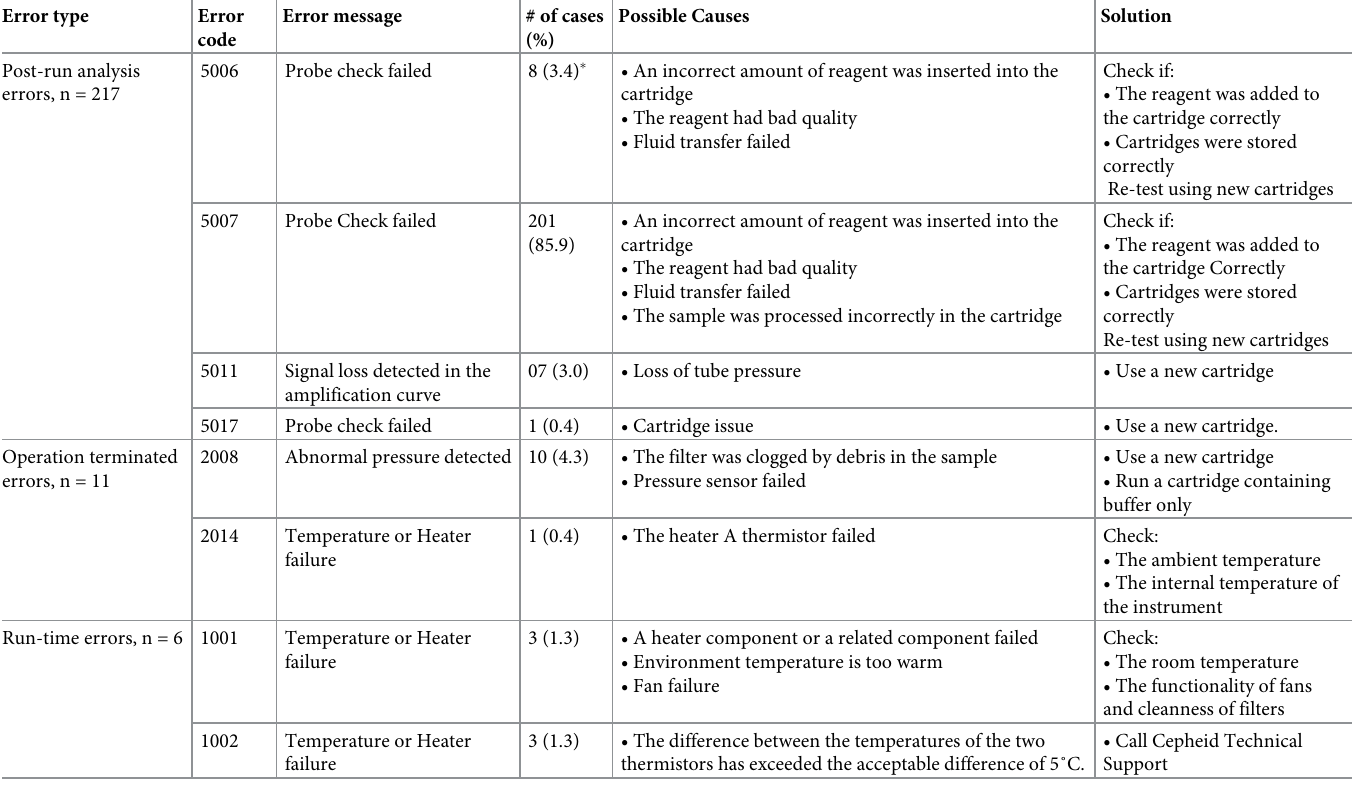
Table 6. Errors that occurred during Xpert MTB/RIF testing in 2018, N = 234 error codes. Error